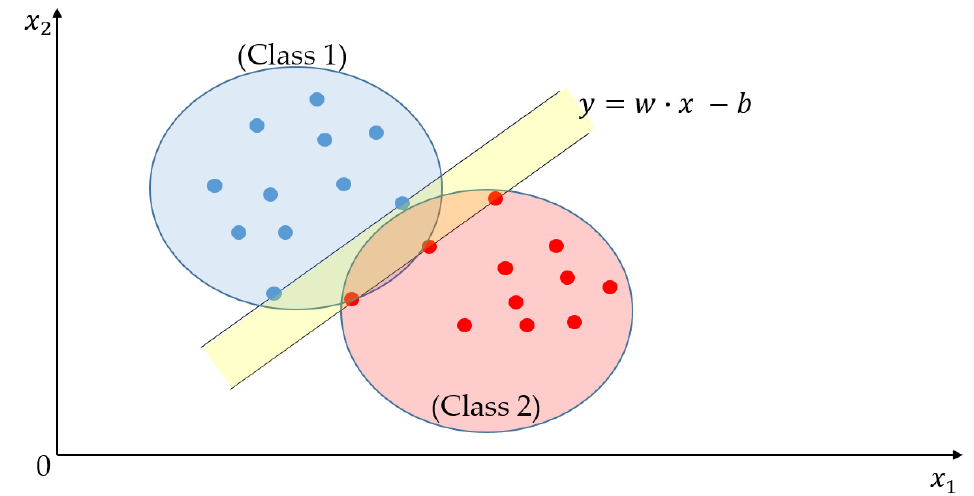
Figure 5. SVM method for finding the hyper-plane for the classification